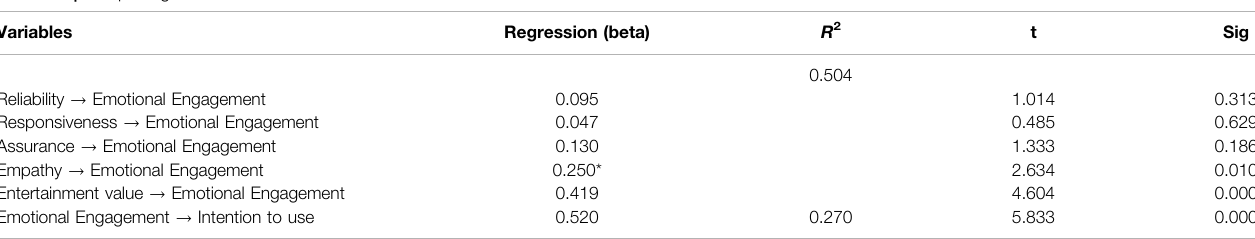
FIGURE 2 | The Servbot model.